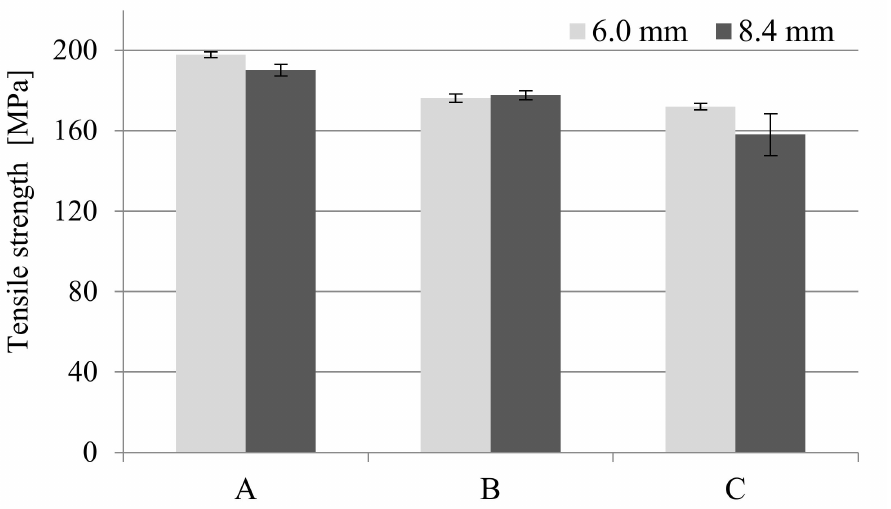
Figure 6. Influence of nitrogen pressure on the tensile strength for unfoamed and foamed thick- walled PA66 GF30 molded parts, where A is a solid sample, while B and C are foamed at 16 and 20 MPa nitrogen pressure